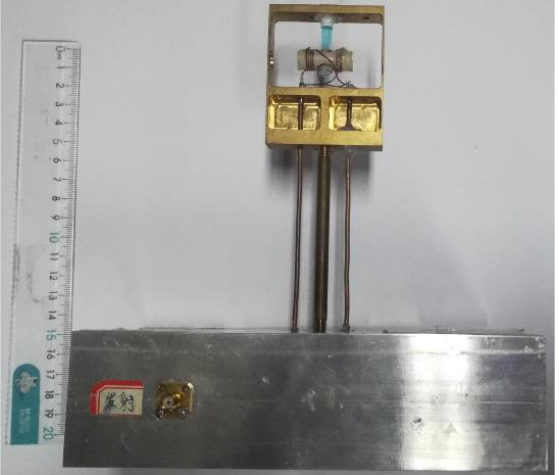
Figure 10. The remote reactance three- stage Π -type matching for the orthogonal dual-coil probe.